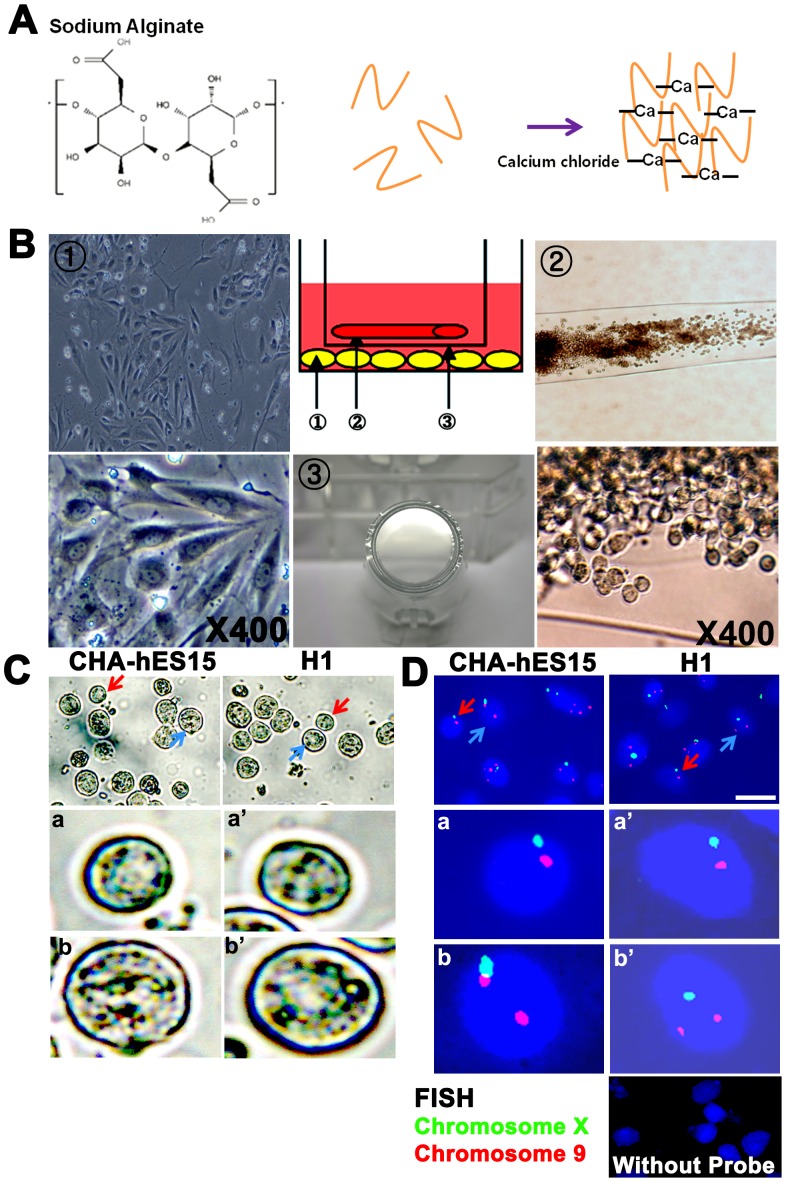

In vitro culture of GSC-like cells using a 3D-co-culture system and the potential for differentiation into germ cell lineagesI.(A) Schematic of calcium-crosslinked alginate; Soluble alginate in saline was mixed with CaCl2 solution. The diffusion of calcium ions into the surrounding solution induces the crosslinking of the soluble alginate and the formation of hydrogels. (B) 3D-co-culture system; The encapsulated GSC-like cells were passed through a strainer (insert), cultured in 6-well culture dishes and differentiated into testicular cells; (1) Human testicular cells (2) Encapsulated GSC-like cells (3) Strainer (insert) (C) Putative differentiated germ cell with a diameter of 15–25 µm. Red arrows, a and a′ indicated putative differentiated germ cell. And blue arrows, b and b′ indicated non-meiotic cell in 3D-co-culture group (from CHA-hES15 and H1 cell lines). (D) FISH analysis of in vitro differentiated GSC-like cells from hESCs; Red arrows, a and a′ indicated normal nucleus with meiotic cells (haploid; n) of chromosomes X (spectrum green) and 9 (spectrum red). And blue arrows, b and b′ indicated non-meiotic cells (diploid; 2n) of chromosomes X (spectrum green) and 9 (spectrum red) in 3D-co-culture group (from CHA-hES15 and H1 cell lines). Scale bars are 20 µm.